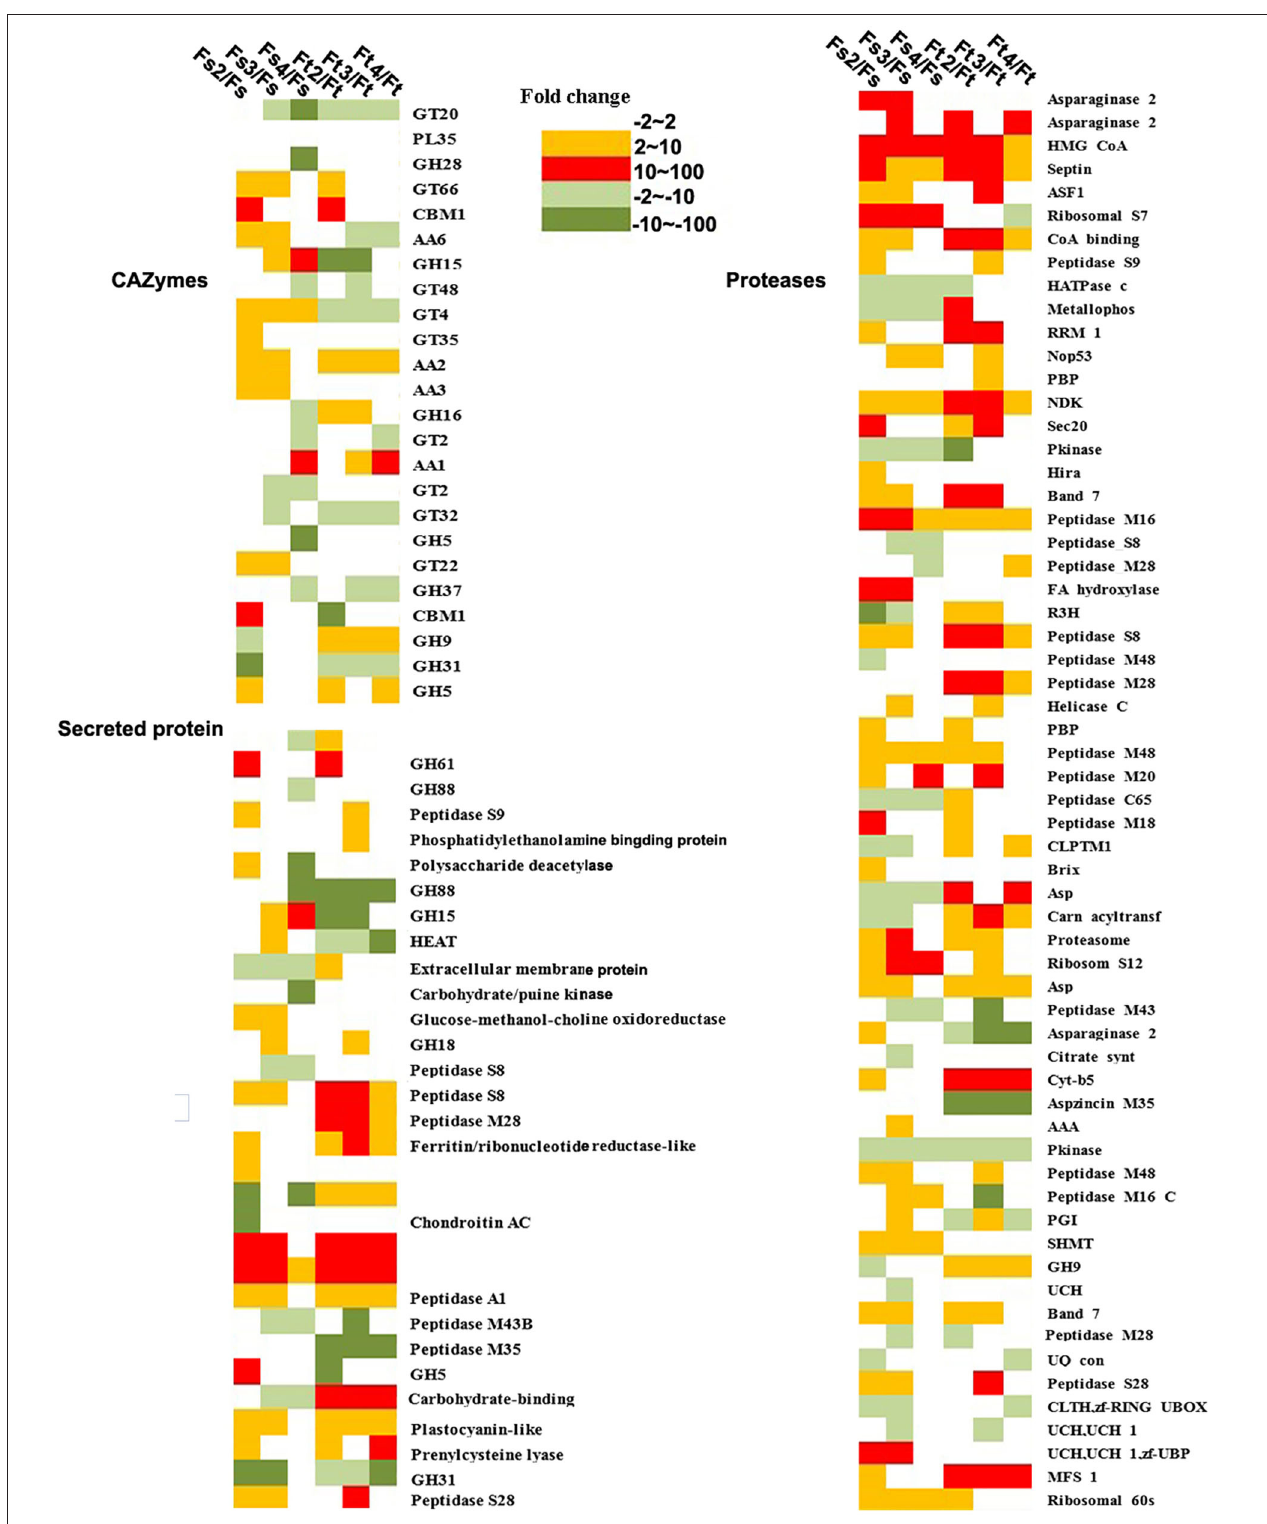
FIGURE 7 | Heatmap showing the expression profile of fungal orthologous genes encoding CAZyme, secreted proteins, and protease during symbiotic germination of D. officinale with Tulasnella sp. and Serendipita sp. The expression level was evaluated using fold change in different colors. Green color (dark green means expression level with fold change ≥ 10) means genes down-regulated expression and red and orange color means genes up-regulated expression (red color means expression level with fold change ≥ 10). Ft2, Ft3, and Ft4 represent Tulasnella sp. in symbiotic statuses 2, 3, 4 stages while Fs2, Fs3, and Fs4 represent Serendipita sp. in symbiotic statuses 2, 3, and 4 stages (according to germination stage) and Ft and Fs means free-living mycelium of Tulasnella sp. and Serendipita sp., respectively.